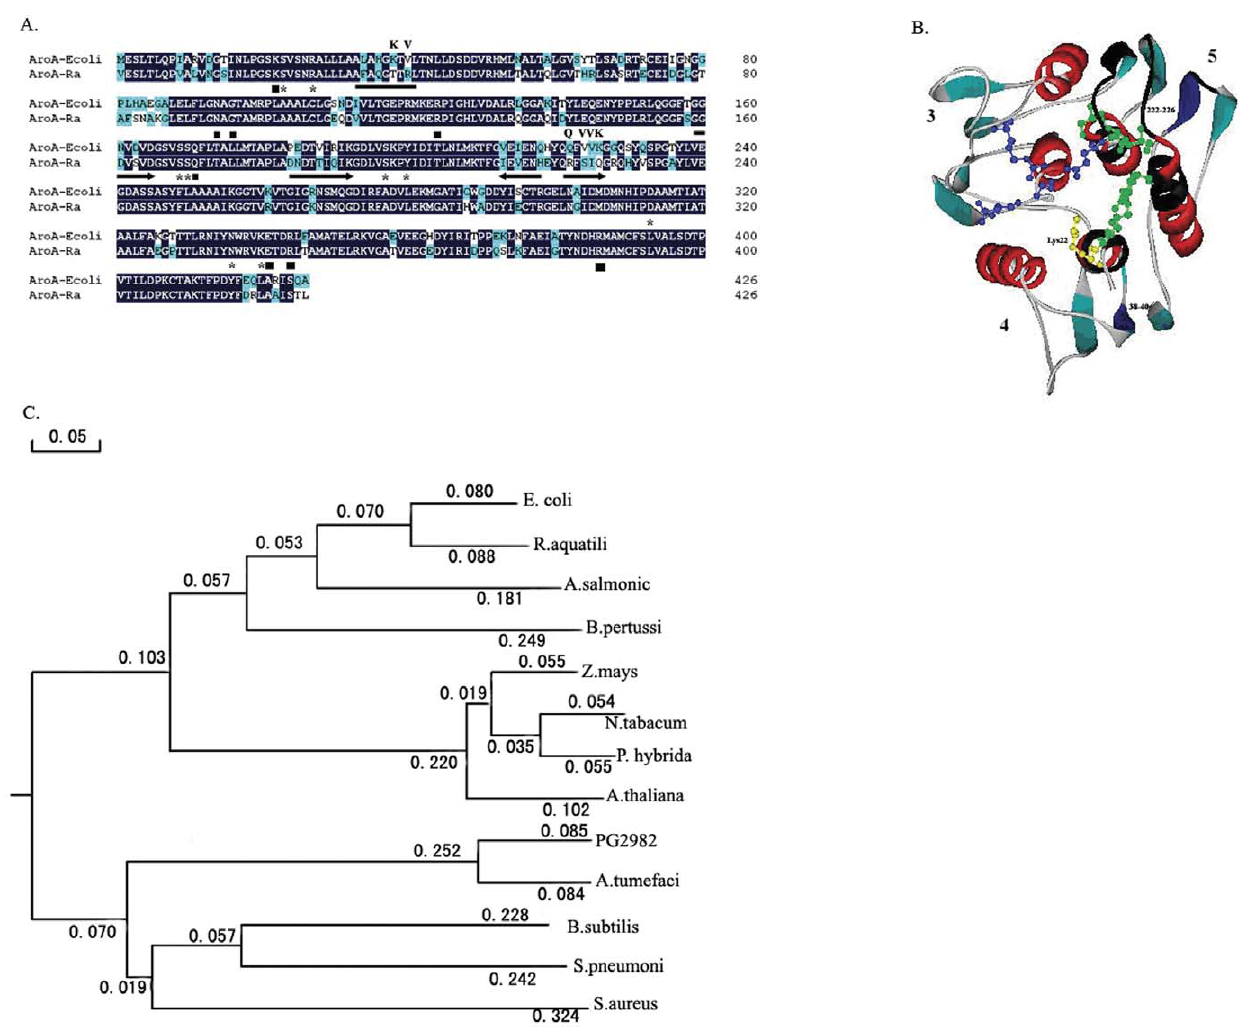
Figure 2. Sequence analysis of the AroA protein from R.aquatilis G20. (A) Protein sequence comparison of both AroA protein from R. aquatilis G20 and E. coli . Amino acids for S3P binding are indicated as asterisks, and amino acids for PEP binding are indicated as squares. The arrow shows the b -sheet in the secondary structure of the subdomain 5. Residues that were mutated in this study were also showed. (B) Views down the axis of the N-terminal domain of the model of AroA R.aquatilis (AroA-Ra). Each subdomain is numbered according to Stallings et al (30). The proposed S3P and PEP binding residues are rendered in CPK. Residues in chemical shift upon S3P binding are indicated in black. The mutant regions were displayed using blue color. (C) Phylogenetic analysis of AroA constructed using DNAMAN. The tree suggests that AroA R.aquatilis belonged to Class I AroA protein. Class I AroA proteins were obtained from E. coli (P07638), Aeromonas salmonicida (Q03321), Arabidopsis thaliana (P05466), N. tabacum (P23981), Petunia hybrida (P11043), Z. mays (CAA44974), and Bordetella pertussis (P12421). Class II AroA proteins were obtained from Pseudomonas strain PG2982 (P56952), A. tumefaciens strain CP4 (Q9R4E4), Bacillus subtilis (P20691), S. aureus (Q05615), and S. pneumoniae (Q9S400).